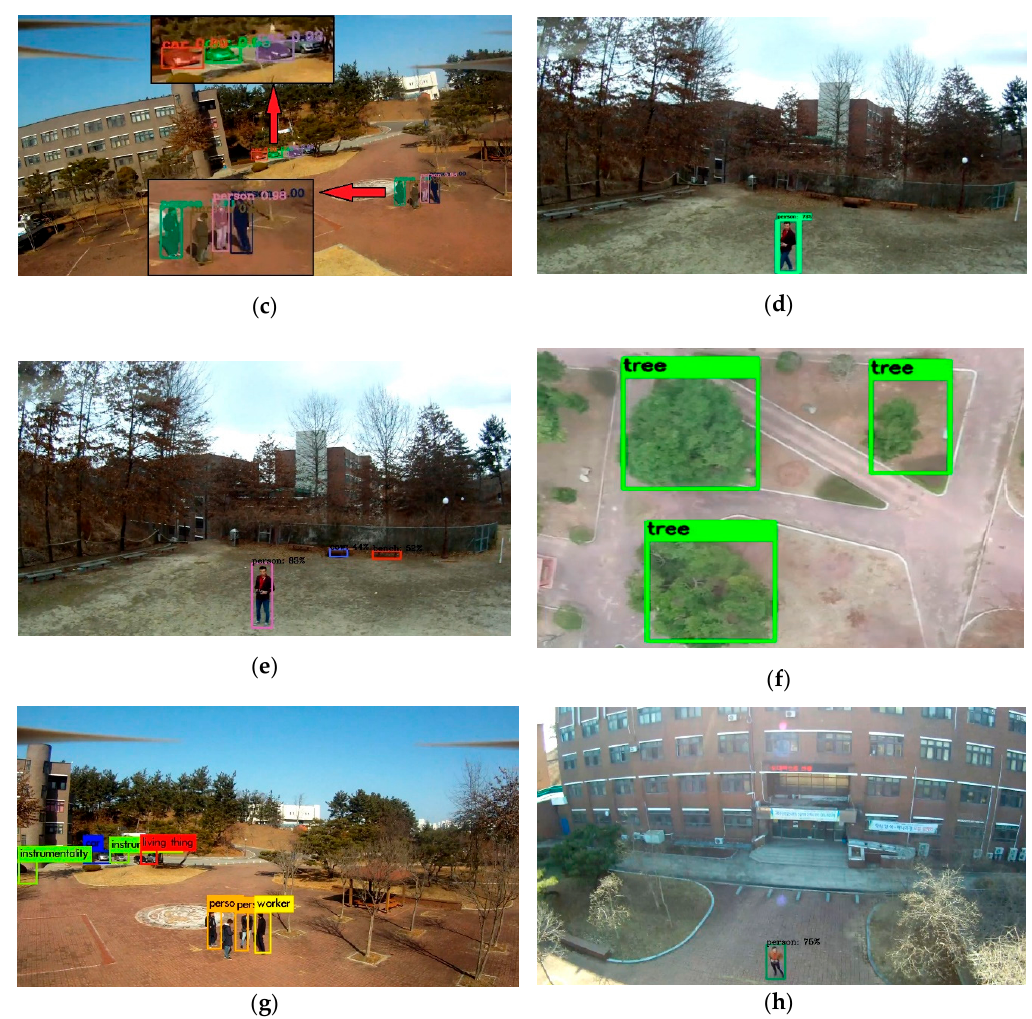
Figure 14. Target detection results using the o ff -board GPU-based ground station: ( a ) Real-time segmentation using DeepLabv-3, ( b ) YOLOv3, ( c ) mask-R-CNN, ( d ) SSD-Mobilenet, ( e , f ) YOLOv2, ( g ) YOLO-9000m, and ( h ) YOLOv3.